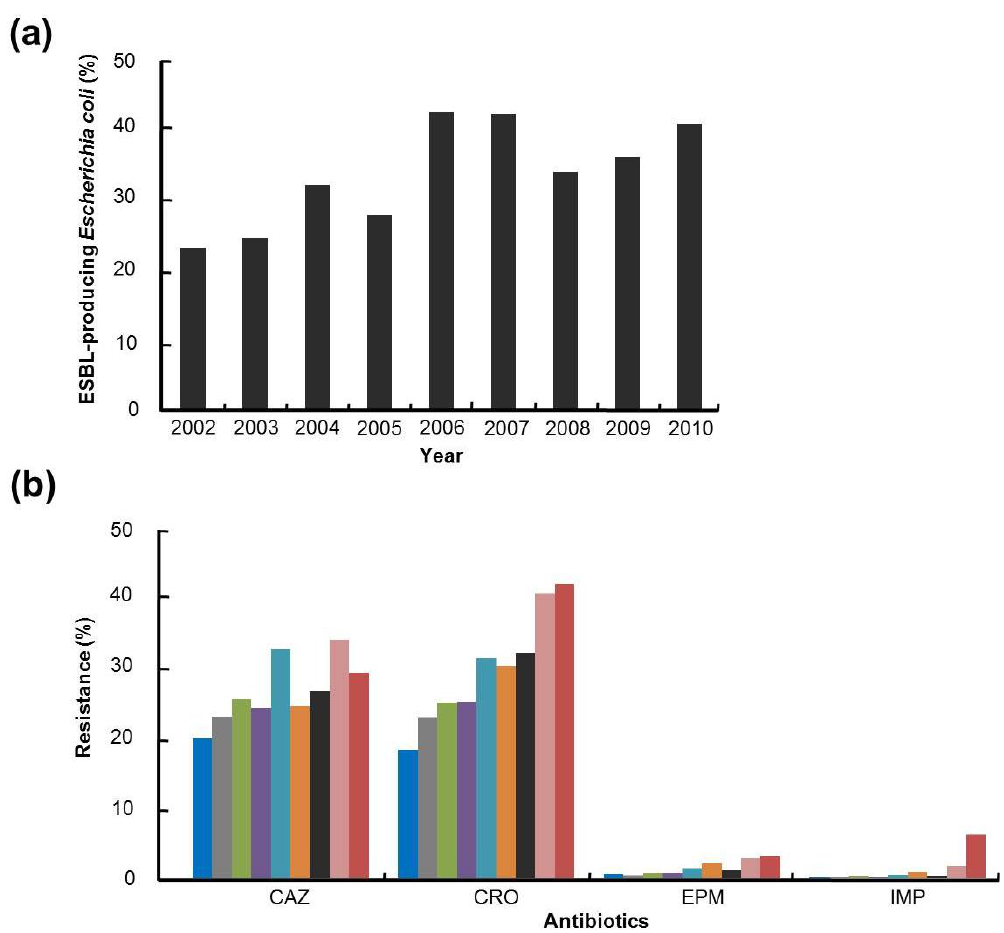
Figure 2. ( a ) ESBL-producing rates (%) in Escherichia coli isolated from intra-abdominal infections in the Asia-Pacific region from 2002–2010 results from the study for SMART. ( b ) Resistance rates (%) for various antibiotics (CAZ: ceftazidime; CRO: ceftriaxone; EPM: ertapenem; IMP: imipenem) in Enterobacteriaceae isolated from intra-abdominal infections (IAIs) in the Asia-Pacific region from 2002–2010 (2002, blue; 2003, gray; 2004, green; 2005, purple; 2006, sky-blue; 2007, orange; 2008, black; 2009, pink; 2010, red) results from the study for